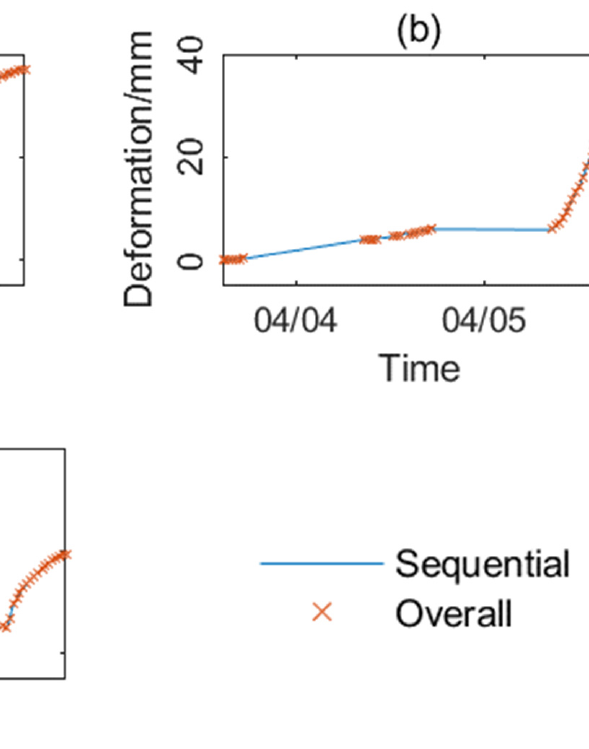
Figure 8. The average deformation rate from 3 April to 4 April 2021 obtained with the sequential estimation method and the three significant deformation regions ( a – c ).